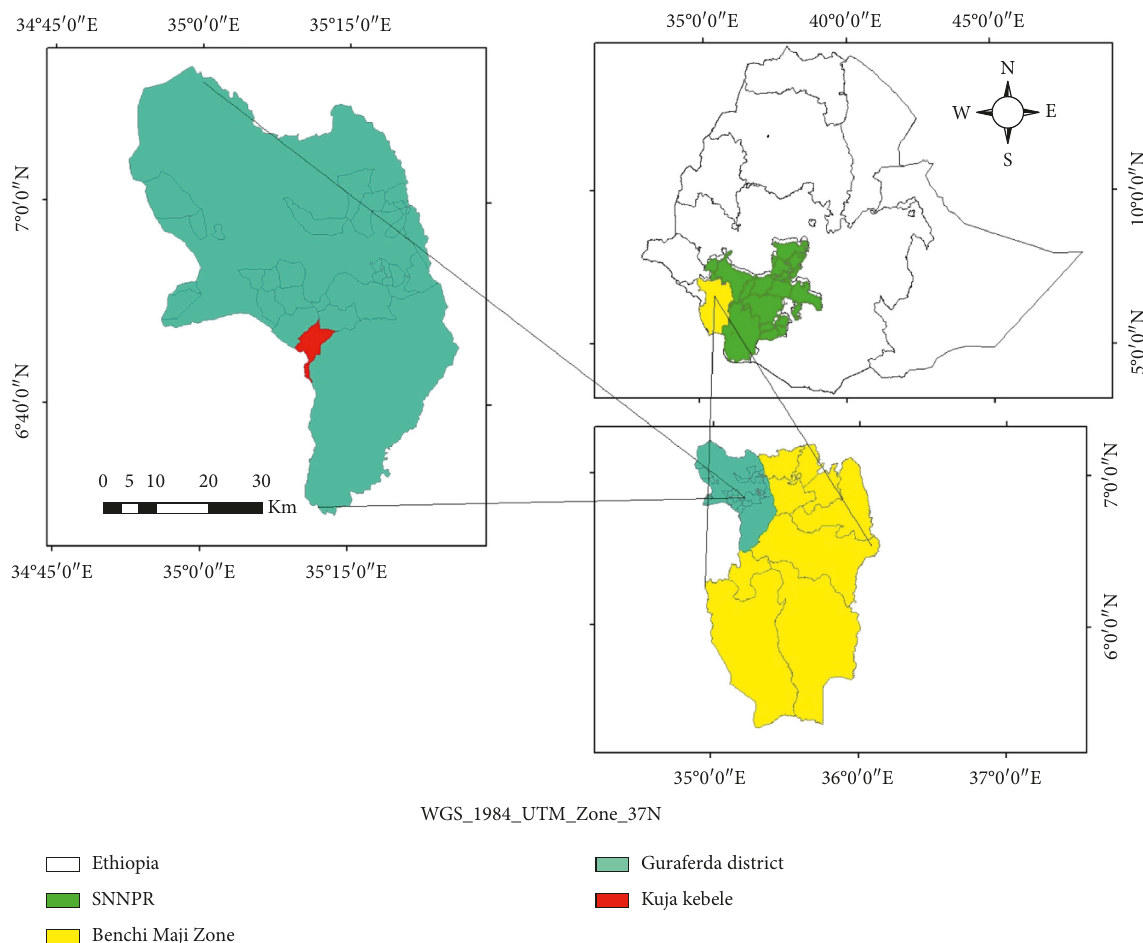
Figure 1: Map showing the experimental site of Guraferda Woreda, Bench Maji, Southwestern